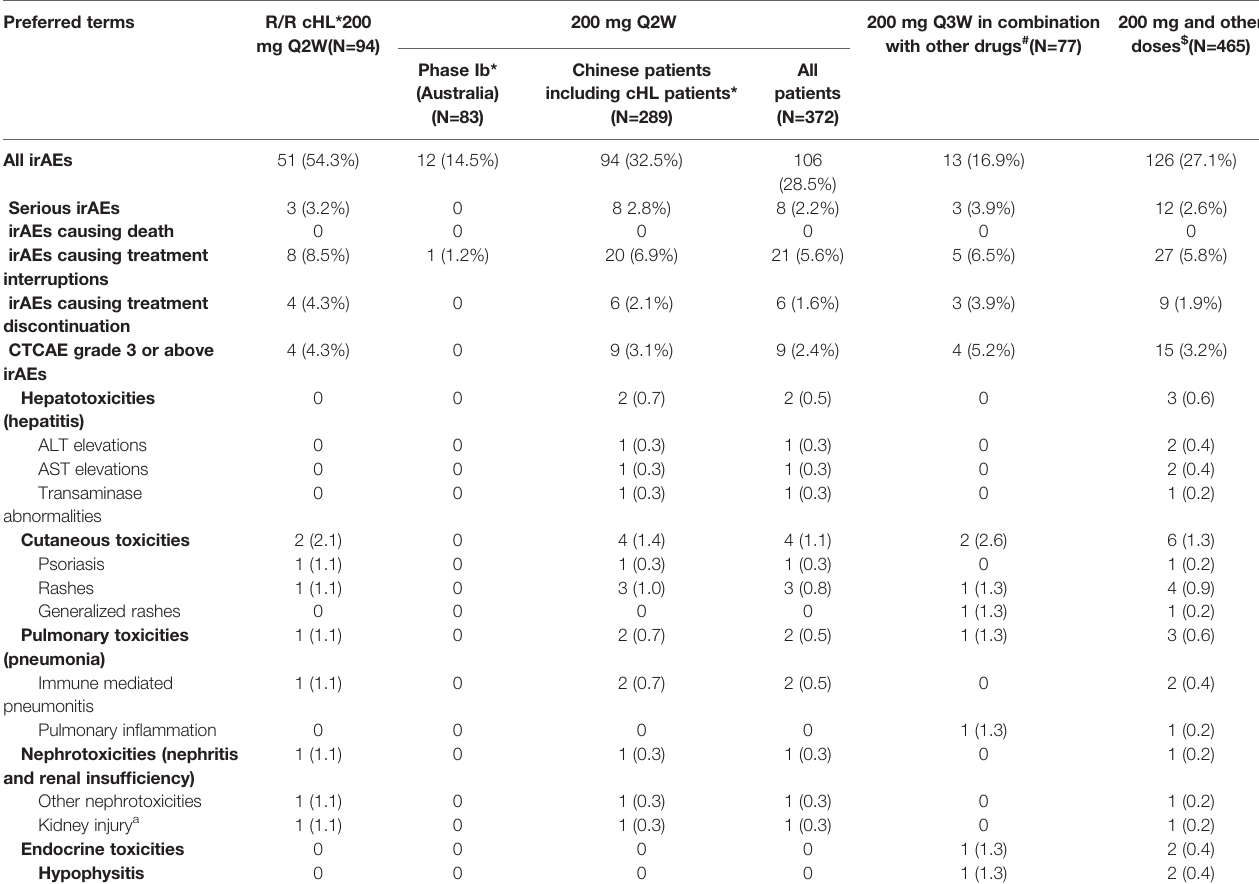
TABLE 3 | Immune-related adverse events (irAEs) in the study